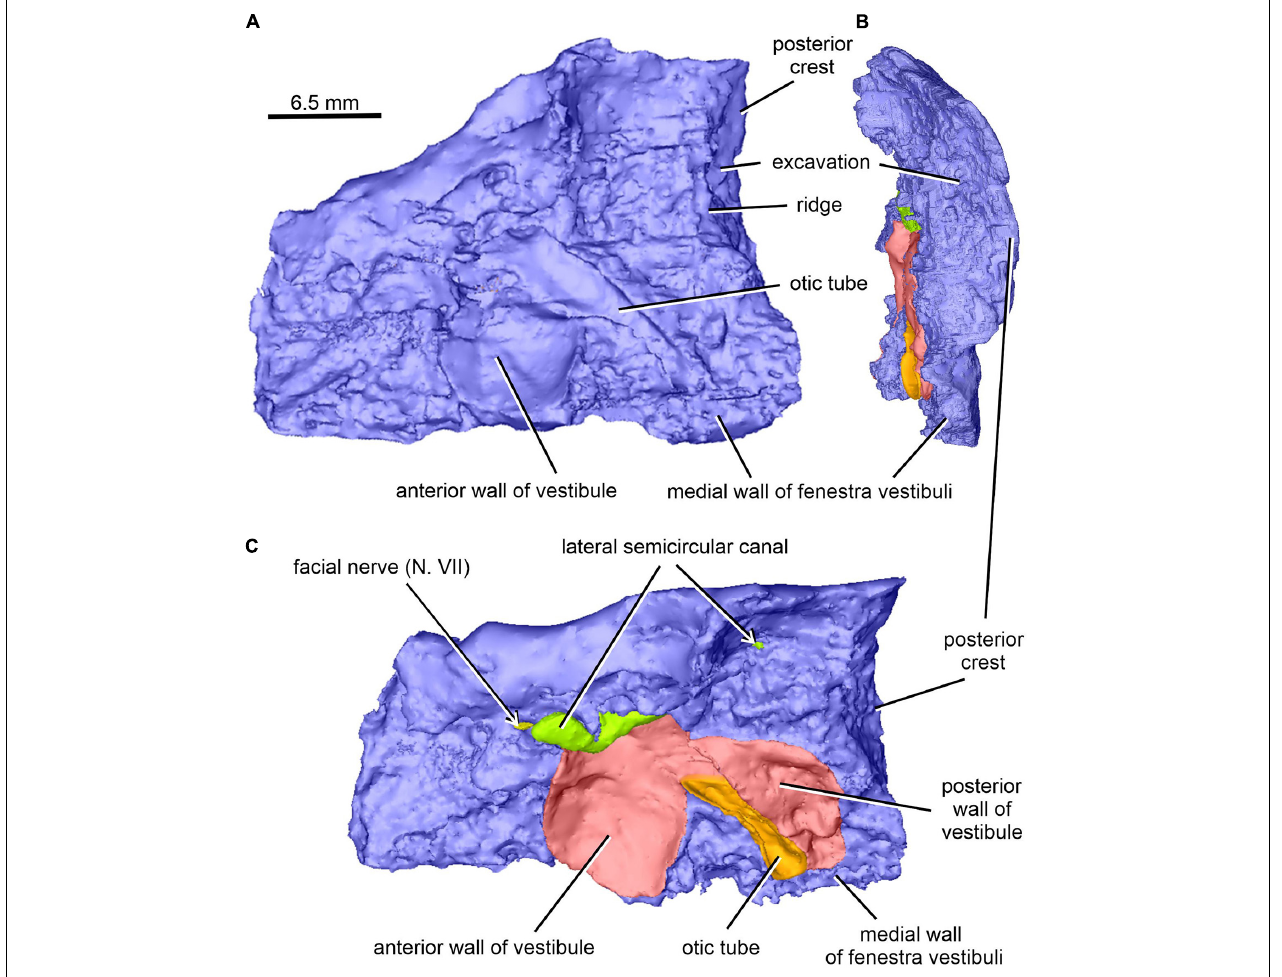
FIGURE 10 | Limnoscelis dynatis , CM 47653. (A–C) Right prootic in medial (A) , posterior (B) , and dorsomedial (C)